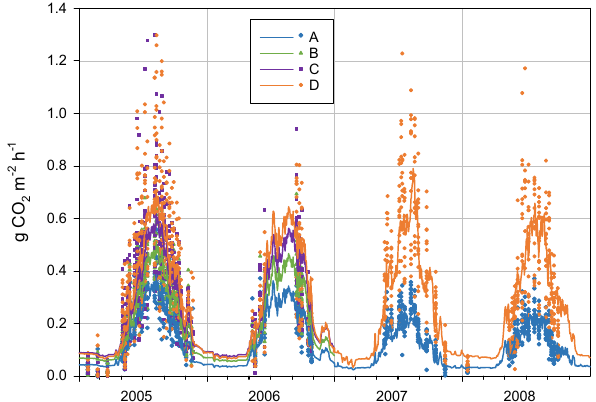
Figure 6. Forest floor CO 2 efflux from different treatment collars in 2005–2008. A: peat, B: peat + litter, C: peat + litter + roots and D: peat + litter + roots + ground vegetation. Points mark individ- ual chamber measurements and lines modelled daily average fluxes (Eq. 1, App. 3). Note that two individual fluxes (9.8.2005) with val- ues 1.80 (D) and 1.84 (C) are outside the graph range, and were excluded as outliers from the regression models (Table